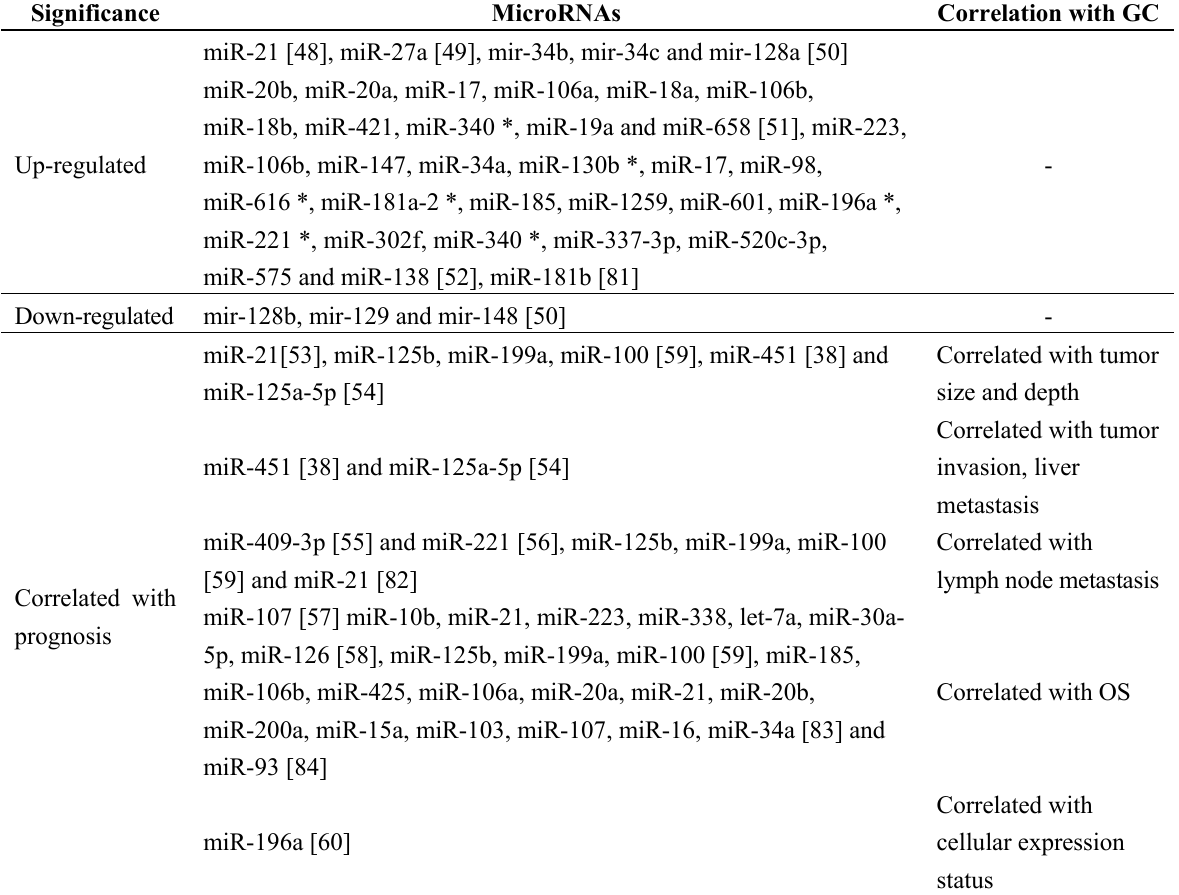
Table 1. miRNAs in the tissue as diagnostic markers for gastric